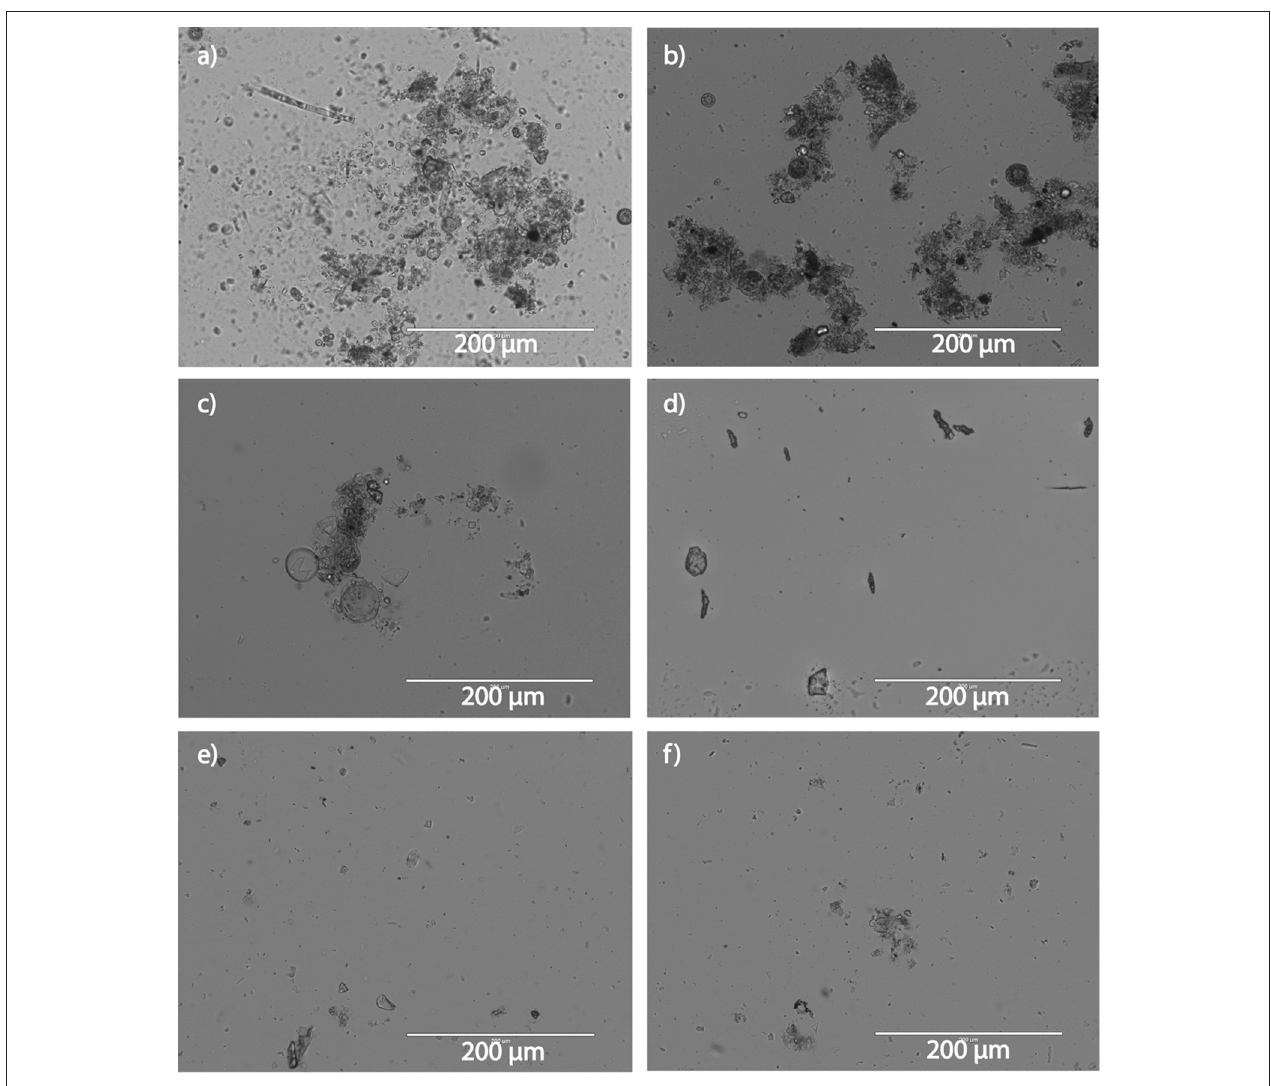
FIGURE 1 | Particle appearance across the salinity transect, from upriver (a) to downriver (e). Scale bars represent 200 µ m. Panel letters correspond to station names from 7/21/14.